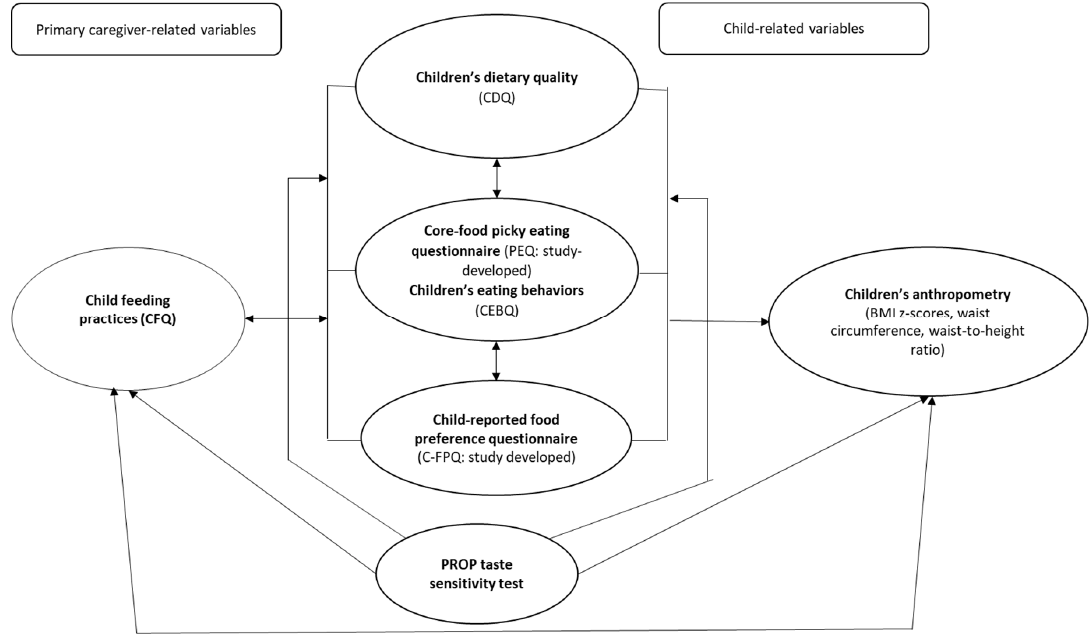
Figure 1. Conceptual framework of the picky eating–bitter taste sensitivity pilot study protocol.